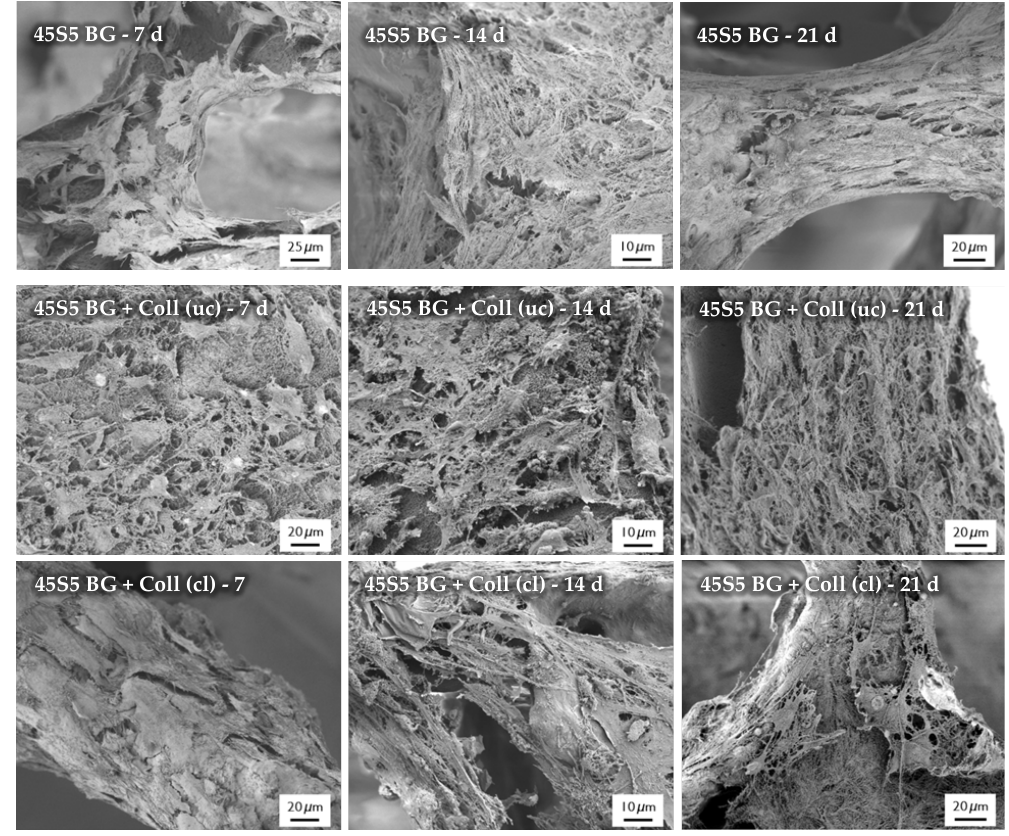
Figure 16. SEM images of seeded MG-63 cells on different types of scaffolds for 7, 14, and 21 days (at different magnifications).